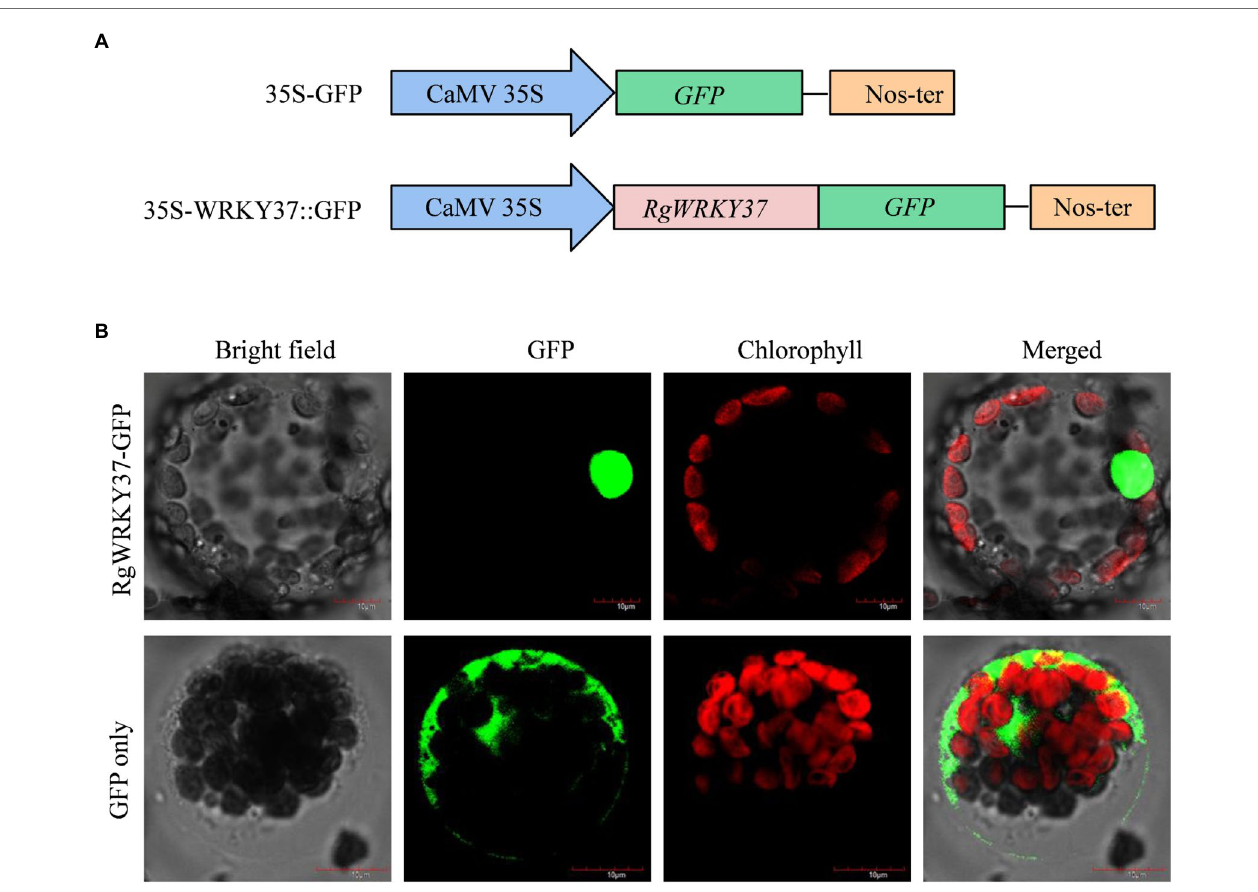
FIGURE 11 | Subcellular localization of the RgWRKY37 protein in tobacco protoplast. (A) Schematic diagram of the 35S-RgWRKY37::green fluorescent protein (GFP) fusion protein construct and the 35S-GFP construct. (B) Transient expression of the 35S-GFP and the 35S-RgWRKY37::GFP constructs in tobacco protoplast. Green fluorescence corresponding to the expressed proteins was observed with a fluorescence microscope 24 h after Agrobacterium